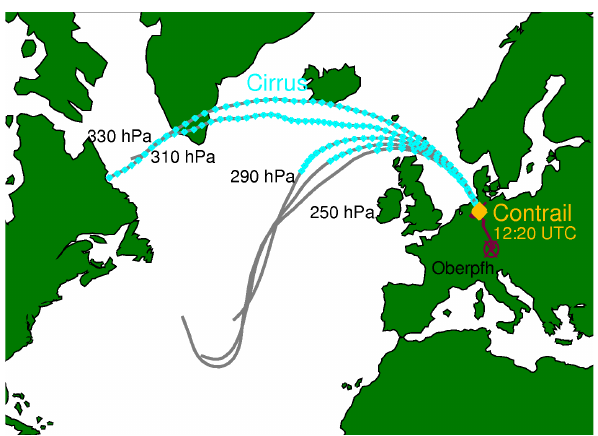
Fig. 9. ECMWF air mass trajectories in different pressure levels, starting approximately at the geographical coordinates of contrail detection on 17 November 2008; turquoise dots represent ECMWF ice.